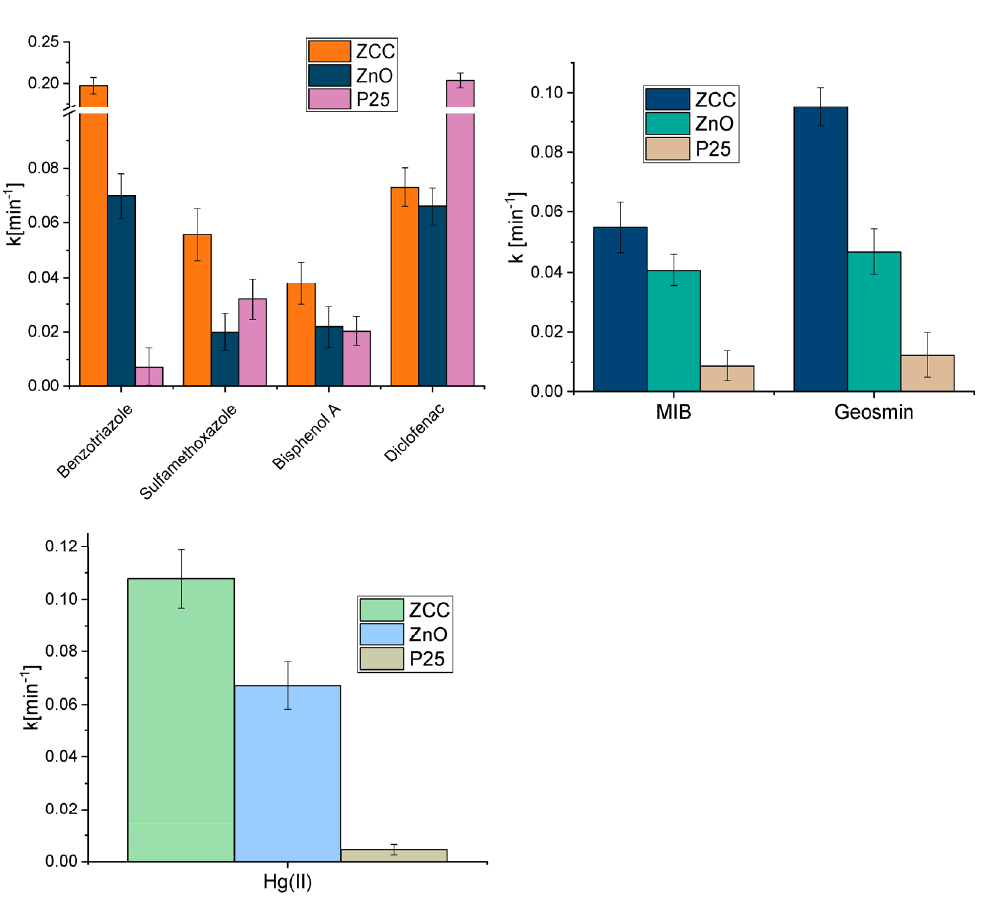
Figure 6. Total Organic Carbon abatement for the mixture of pollutants in the presence of the different photocatalysts.